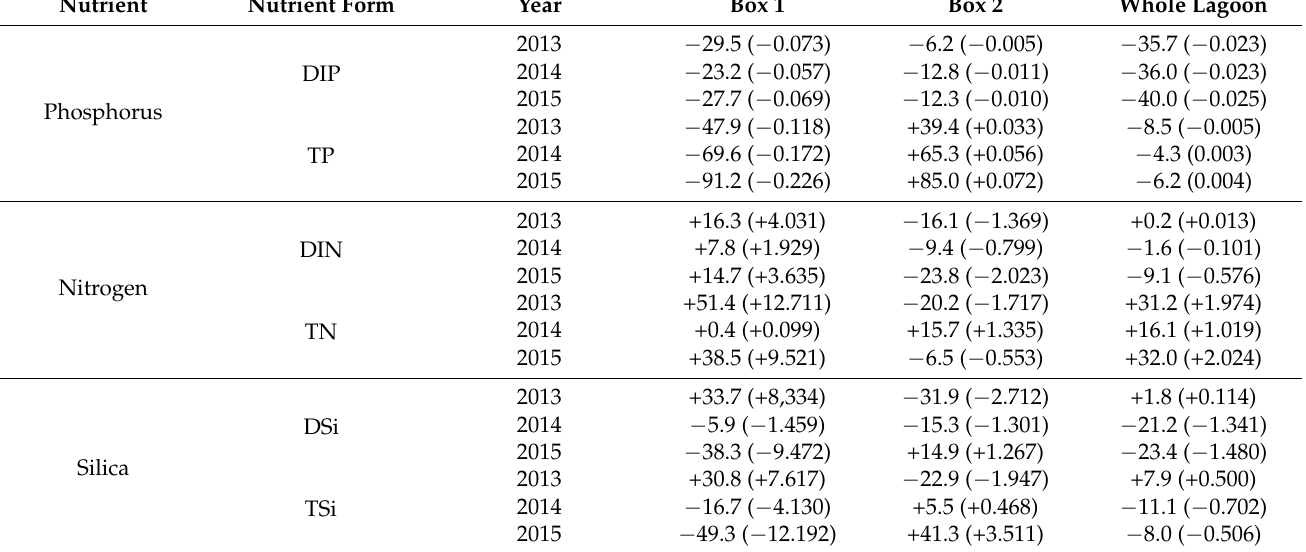
Table 2. Annual net internal transformations of dissolved inorganic and total phosphorus, nitrogen, and silica forms in the Curonian Lagoon. Positive values indicate net production (source) whereas negative values indicate net retention (sink). Net fluxes in Box 1 and Box 2 and at the whole lagoon scale are expressed in 10 3 mol d − 1 (DIP, TP) and in 10 5 mol d − 1 (DIN, TN and DSi and TSi); areal fluxes are reported in brackets and are all expressed in mmol m − 2 d − 1 .